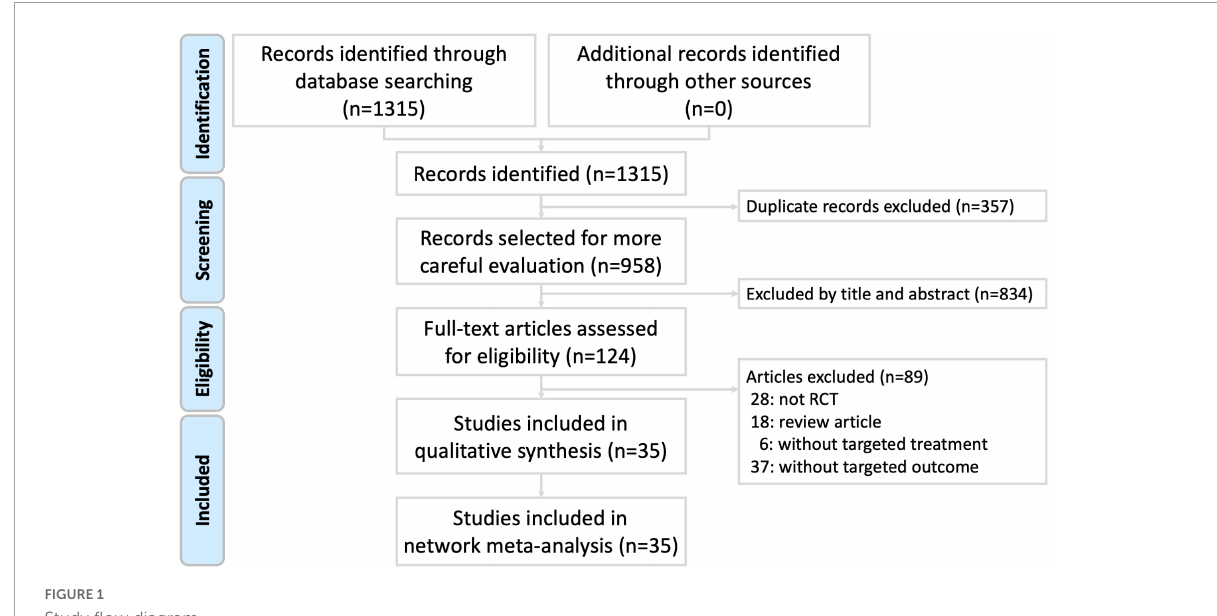
FIGURE1 Study flow